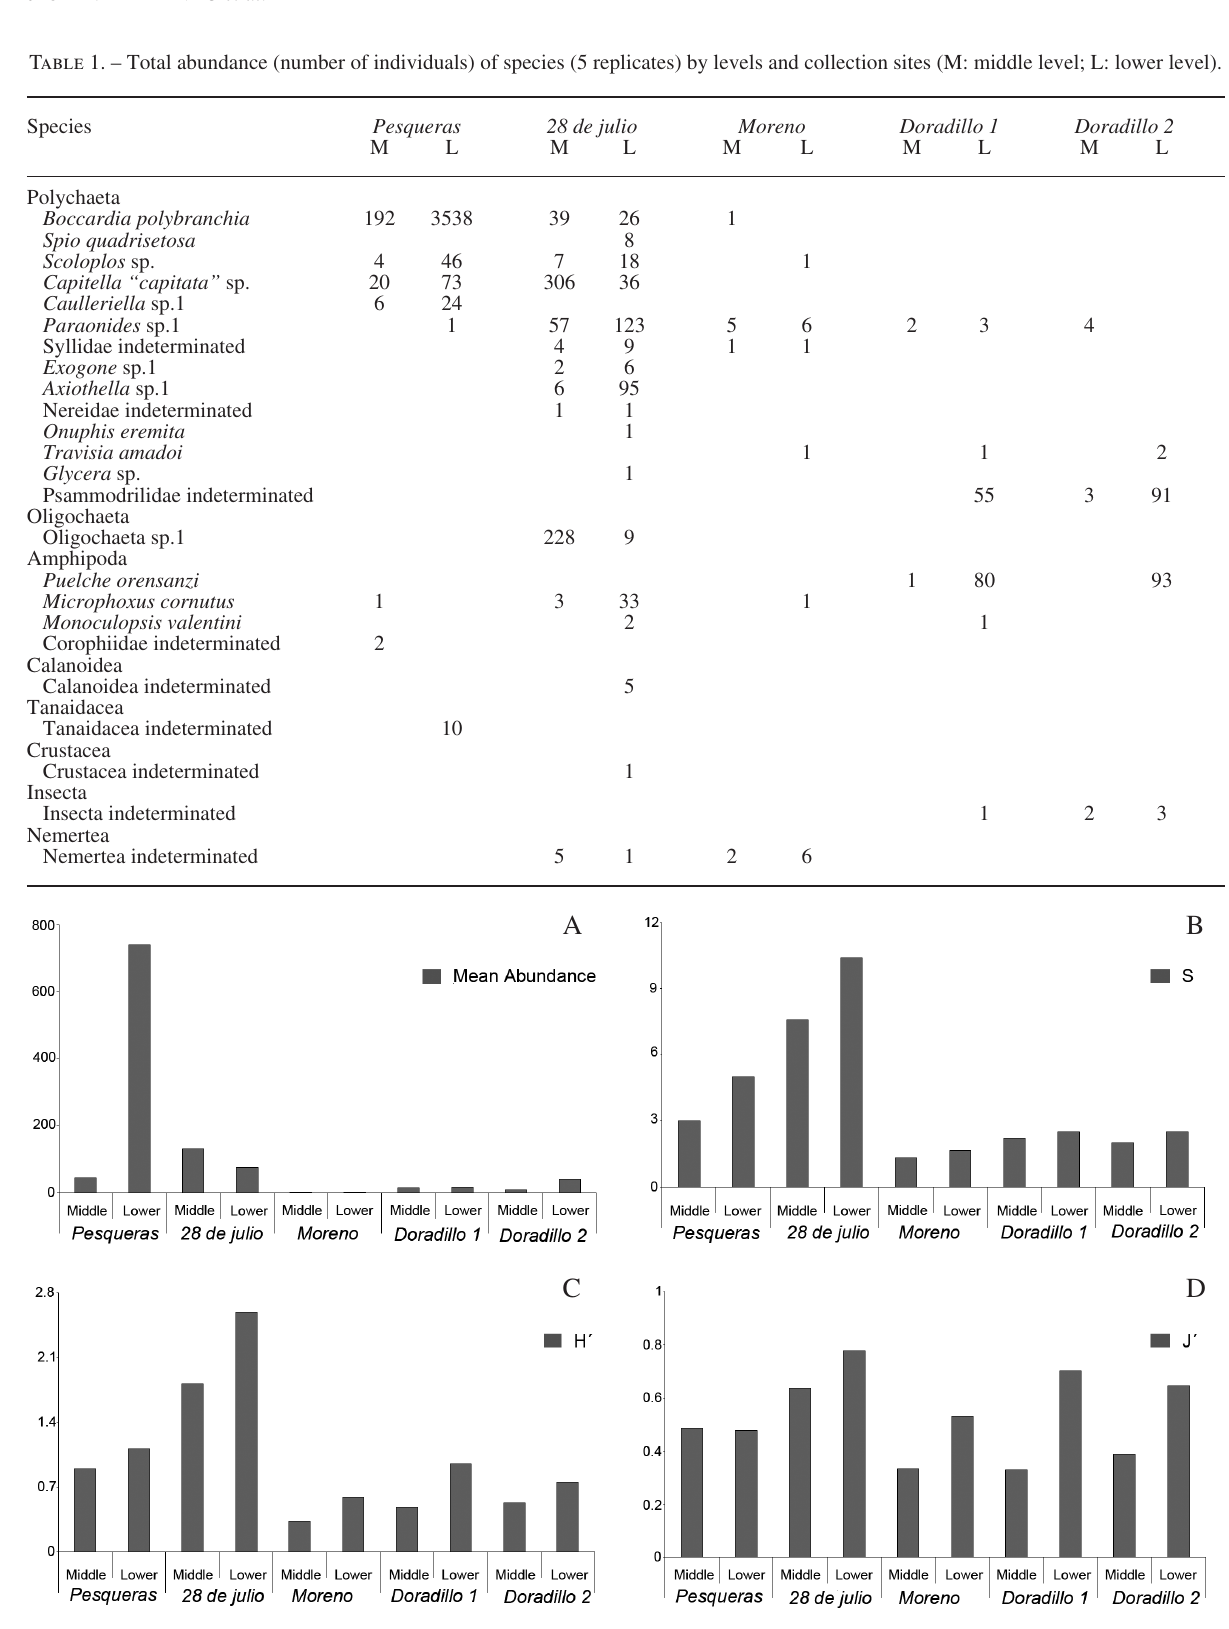
Fig . 2. – Biological variables at the middle and lower levels of the collection sites: A, mean abundance; B, species richness; C, Shannon diversity index and D;